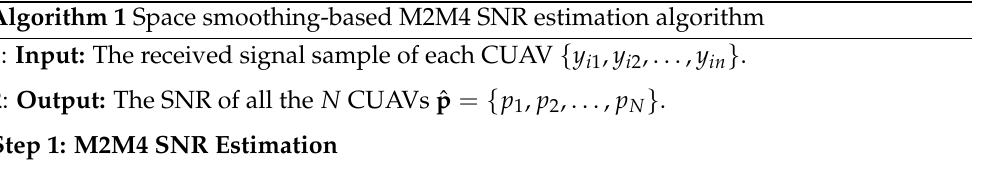
Algorithm 1 Space smoothing-based M2M4 SNR estimation